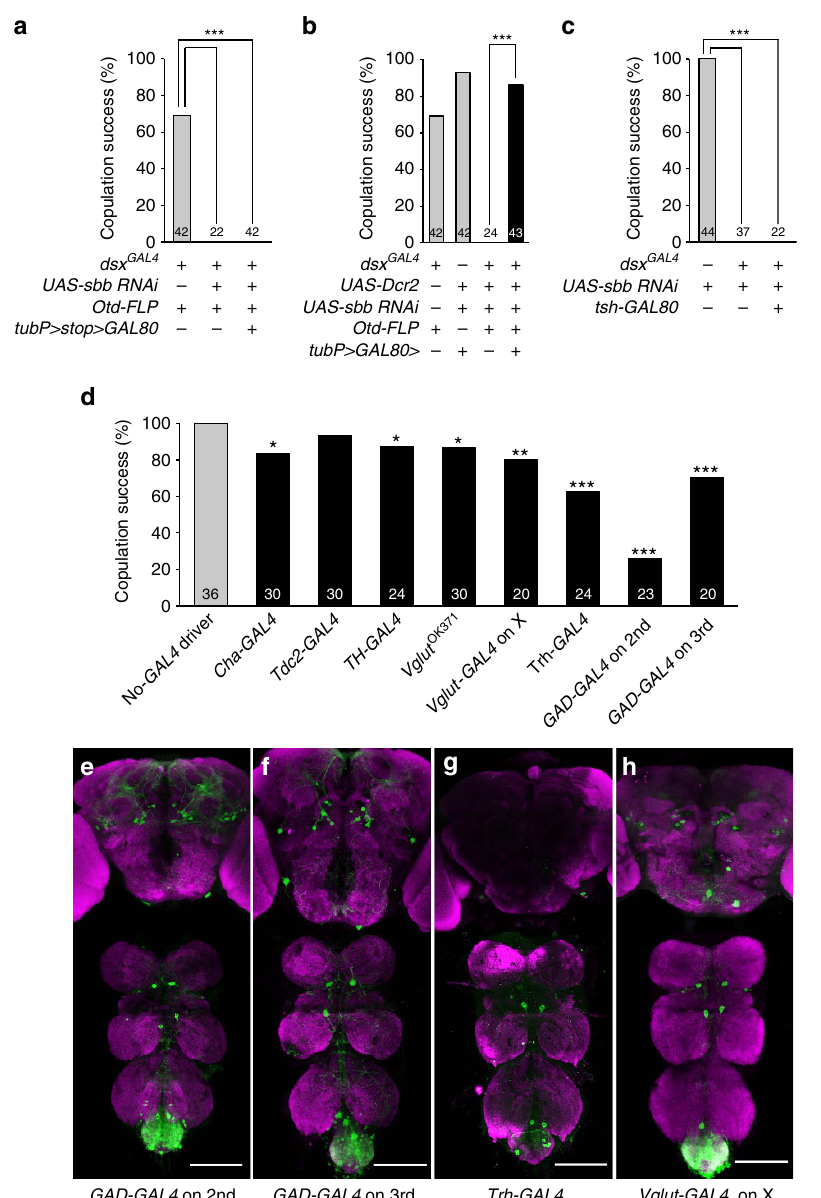
Figure 3 | Effect of sbb knockdown in subsets of dsx neurons as defined by their body region or by the transmitters they synthesize. Effect of head-excluded ( a ), head-specific ( b ) and thorax-excluded sbb knockdown in dsx -expressing neurons ( c ) on copulation. ( d ) Comparisons of GAL4 s defined by transmitters in terms of their effect on copulation when used to drive UAS-sbbRNAi only in dsx -expressing cells by means of tubP 4 GAL80 4 and dsx FLP . ( e – h ) Images of dsx neurons that express GAD-GAL4 on 2nd ( e ), GAD-GAL4 on 3rd ( f ), or Trh-GAL4 ( g ) or Vglut-GAL4 on X ( h ). The genotypes of flies were w; GAD-GAL4 on 2nd/UAS 4 stop 4 mCD8::GFP; dsx FLP / þ ( e ), w; UAS 4 stop 4 mCD8::GFP/ þ ; dsx FLP /GAD-GAL4 on 3rd ( f ), w; Trh-GAL4/ UAS 4 stop 4 mCD8::GFP; dsx FLP / þ ( g ) and Vglut-GAL4 on X ; UAS 4 stop 4 mCD8::GFP/ þ ; dsx FLP / þ ( h ), respectively. * P ¼ 0.05; ** P ¼ 0.01; *** P ¼ 0.001 Scale bar, 100 m